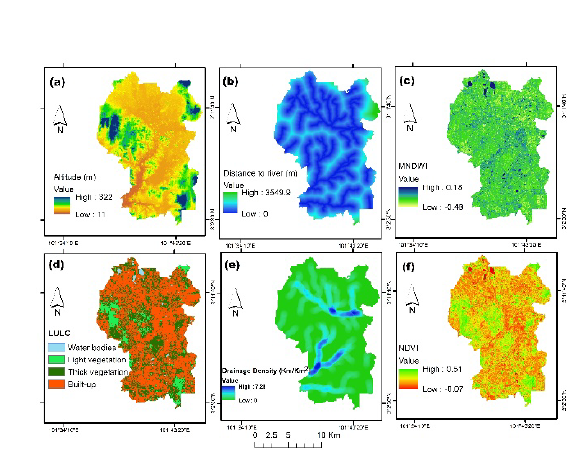
Fig ure 2: Flood criteria; (a) Altitude (b) Distance to river (c) MNDWI (d) LULC (e) drainage density (f) NDVI